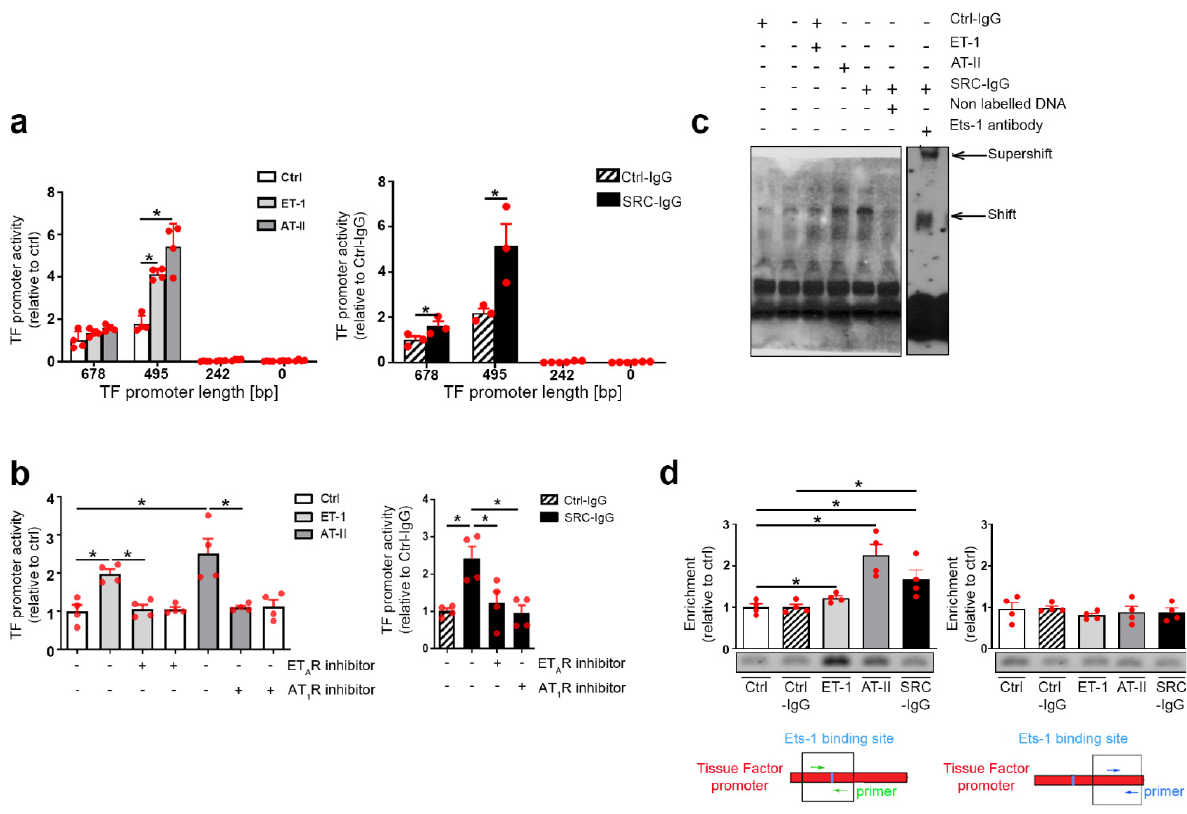
Figure 3. Ets-1 binding to the TF promoter upon AT 1 R/ET A R stimulation by either respective natural peptide ligand or in response to SRC-IgG. ( a ) ( left and right ) Dual luciferase assay shows a TF promoter activity increase in response to either receptor-activating scenarios as compared with non-stimulated or Ctrl-IgG treated cells. ( b ) ( left and right ) Observed activation is abolished by specific AT 1 R or ET A R inhibitors. ( c ) EMSA performed with nucleus proteins of endothelial cells incubated with TF promoter DNA. Shift specificity was assessed using non-labeled DNA, the incubation with Ets-1-specific antibodies triggering a supershift. ( d ) ( left and right ) Chromatin immunoprecipitation (ChIP) performed using stimulated cells, the DNA of which was precipitated with an antibody directed against Ets-1. ( a ) left, ( b , d ) n = 4, ( a ) right, ( c ) n = 3; representative blots are shown. * p < 0.05.